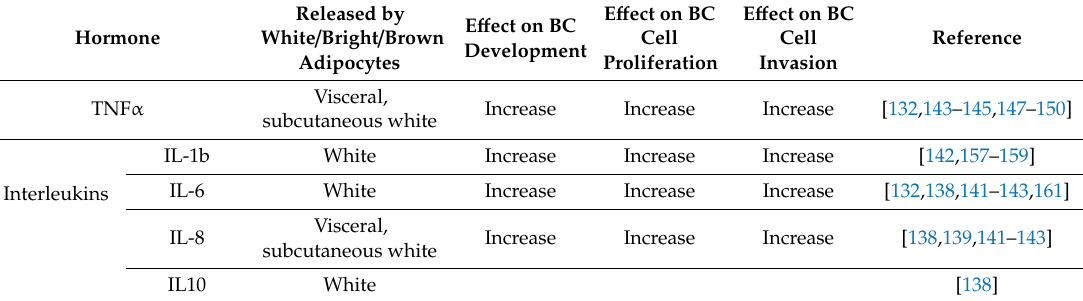
Table 3. Adipocytes regulate breast cancer via released